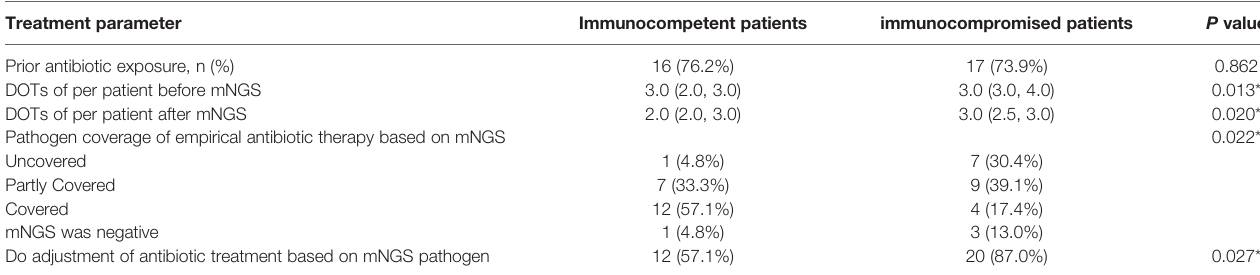
TABLE 2 | The antibiotic treatment strategy before and after mNGS. Treatment